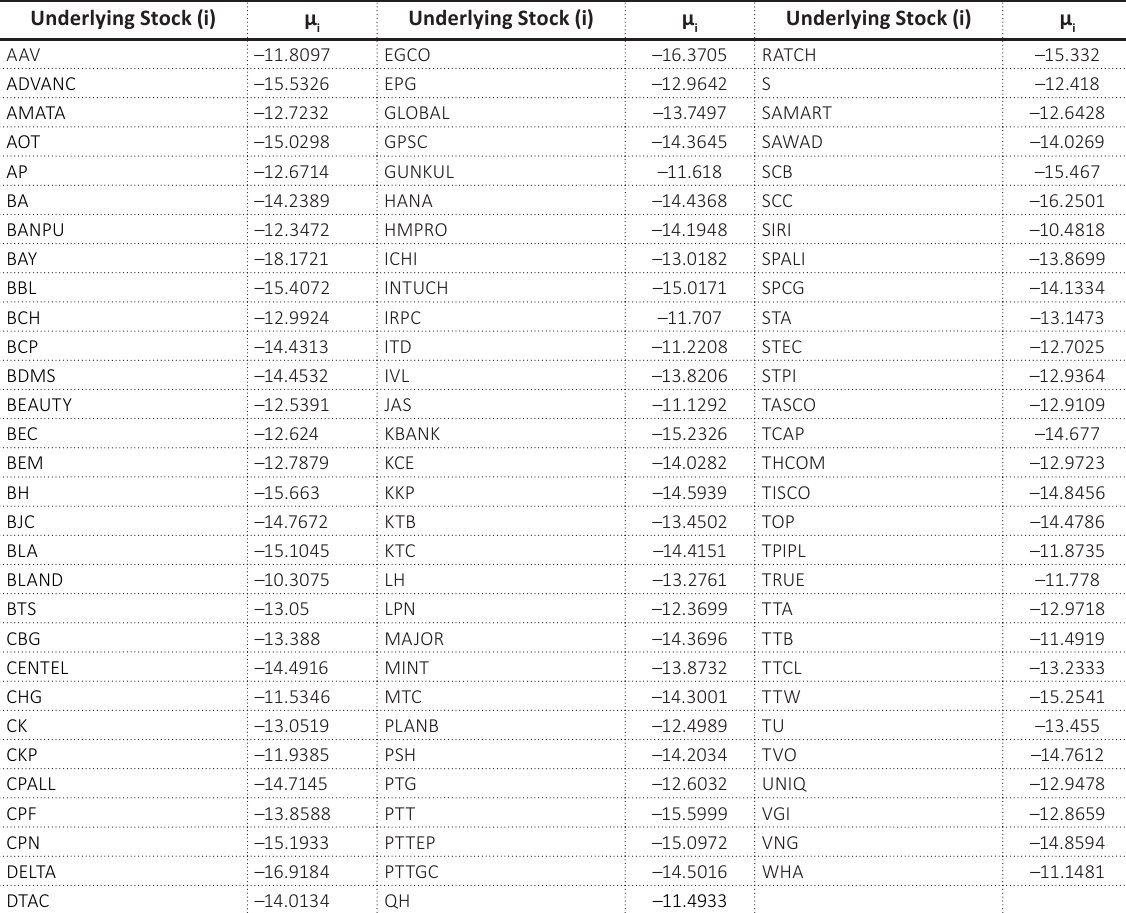
Table A1. The estimation result of fixed parameters for all 89 companies on which stocks